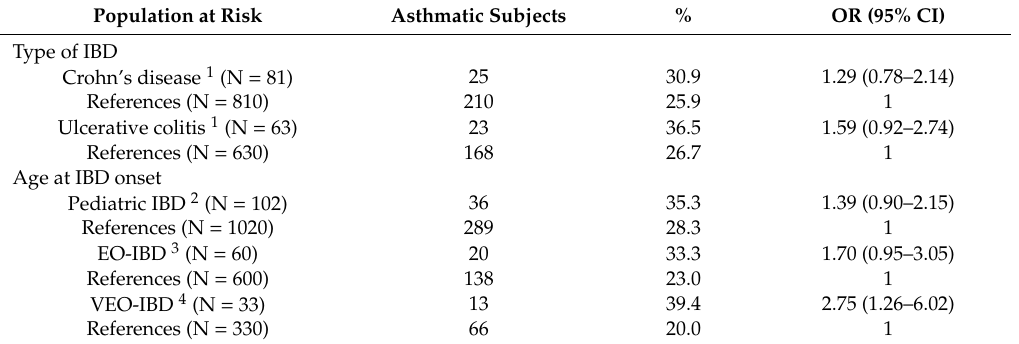
Table 3. Risk of Asthma among Children A ff ected by IBD, Stratified by Type of IBD and Age at IBD